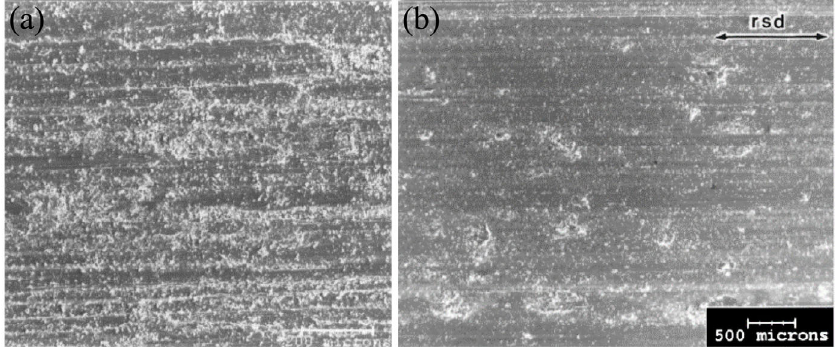
Fig. 26 SEM images of worn surfaces ensuing reciprocated sliding at 5 MPa and after 20,000 cycles: (a) Ti64 (pin); (b) steel counter-face (plate). Reproduced with permission from Ref. [31]. Copyright Elsevier,